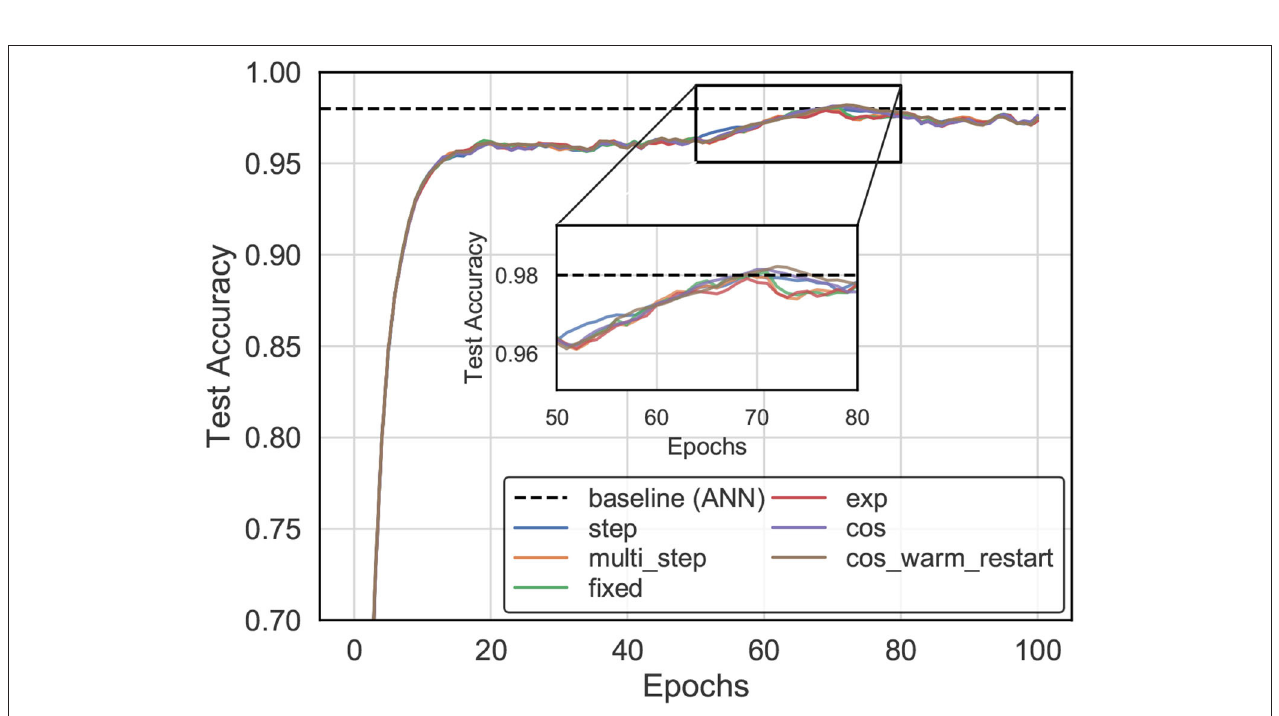
FIGURE 7 | The accuracy evolution curve for training with our method on the MNIST dataset varies as the learning rate schedule.